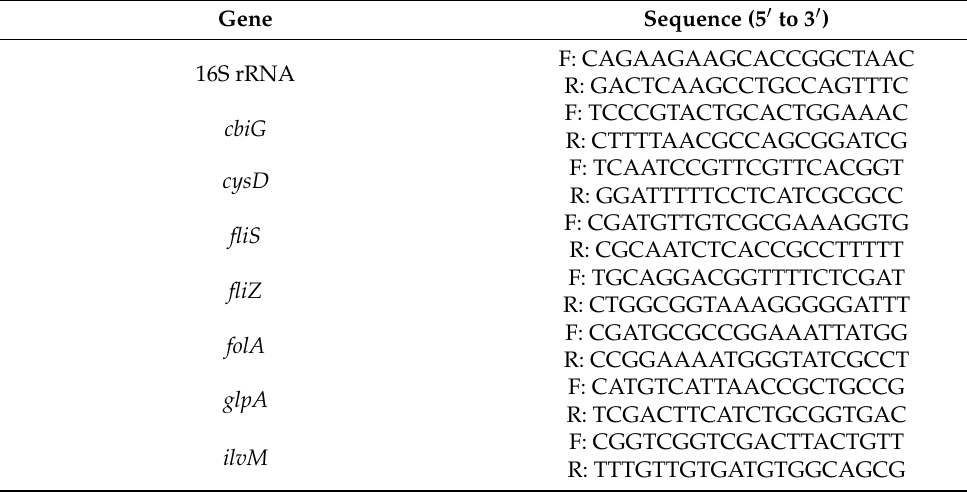
Table 1. Primers used in the gene expression